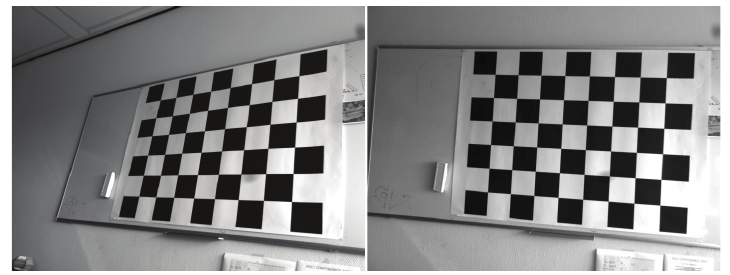
Figure 5. Calibration board from two different camera